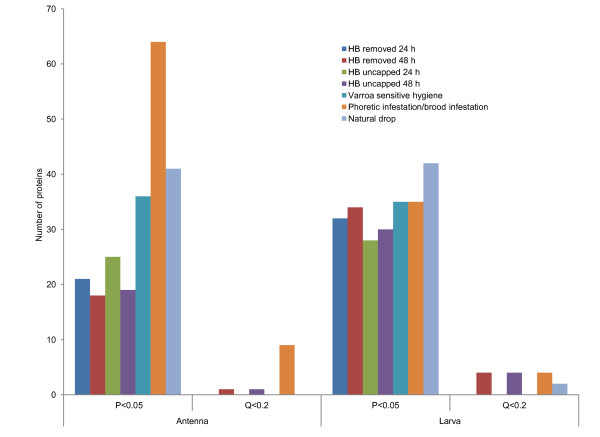
Results of proteome correlation screen for antennal and larval tissues. Bar plot giving the number of proteins found correlating with traits at different cut-off's for statistical confidence.